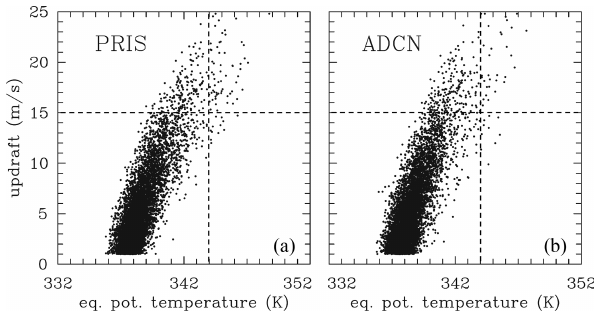
Figure 6. Like Fig. 5, but at 9km for 2MOM (a) PRIS and (b) ADCN. Dashed horizontal and vertical lines show values of 15ms − 1 and